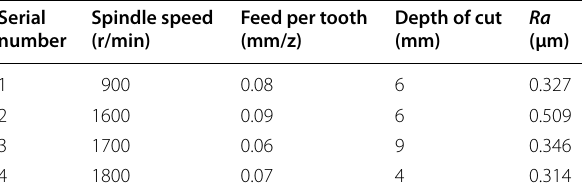
Table 3 Surface roughness value obtained through finite element simulation Serial Spindle speed number (r/min)